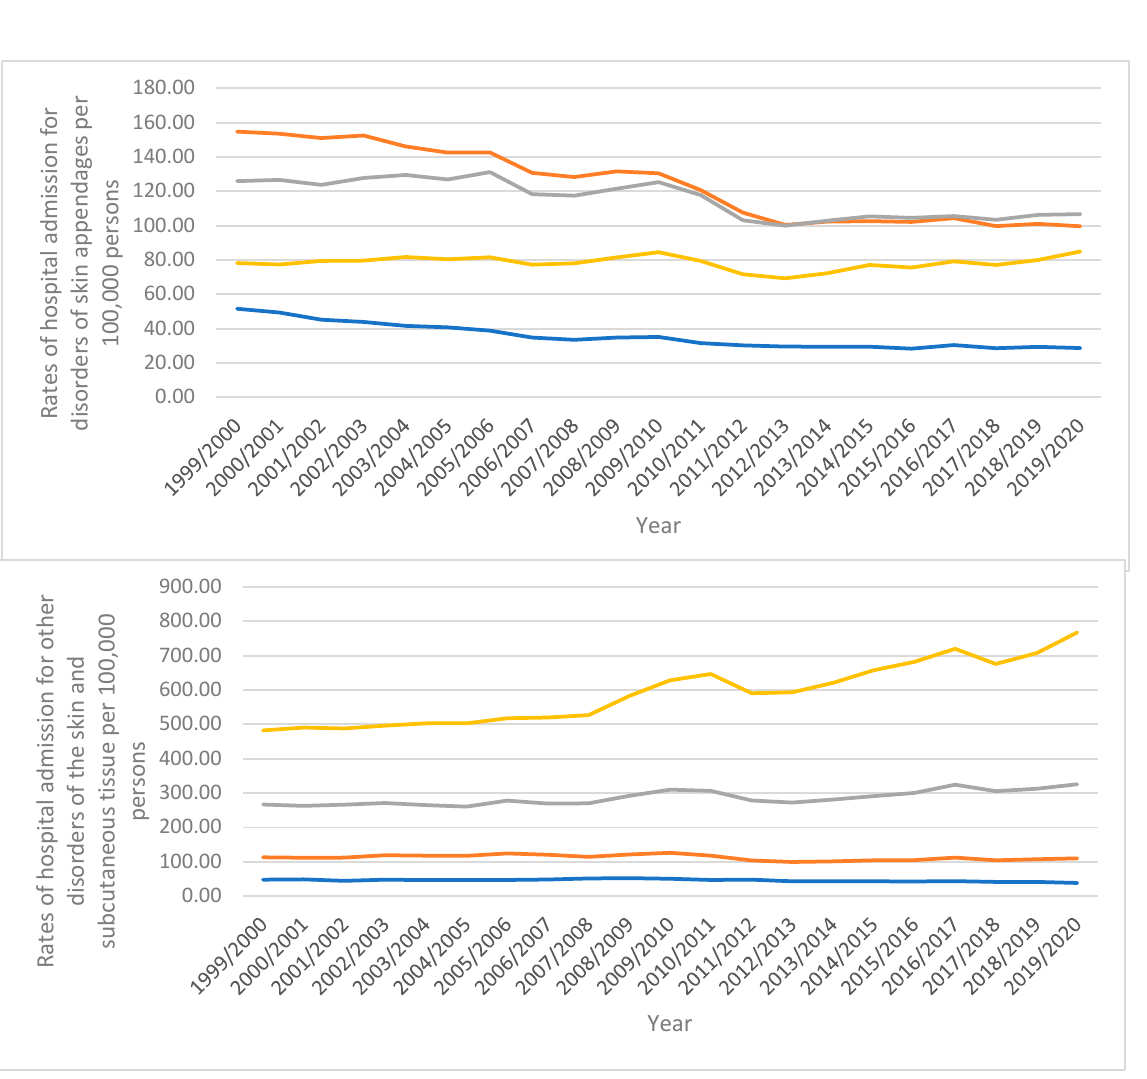
Figure 5. Hospital admission rates stratified by age.